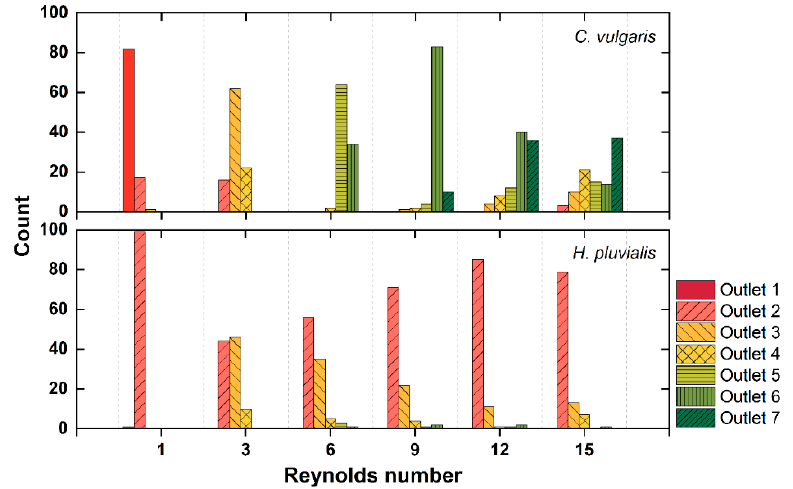
Figure 5. The number of C. vulgaris and H. pluvialis counted at each of seven outlets with Re ranging from 1 to 15 ( n = 100 for each alga).